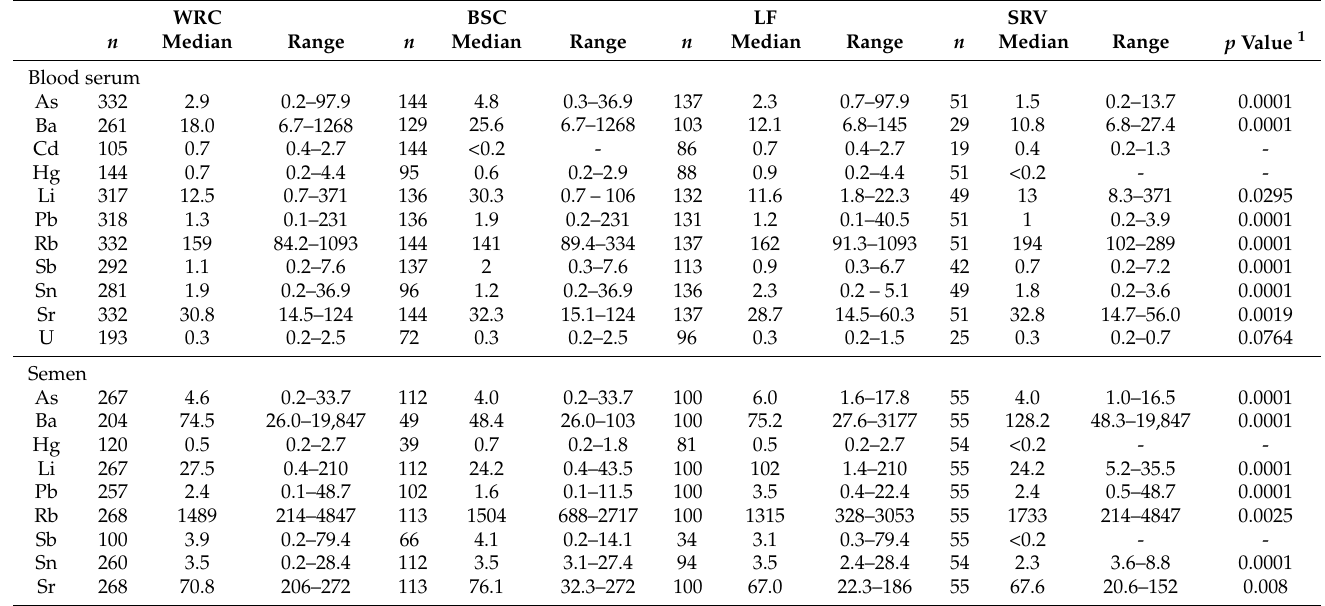
Table 3. Concentration of Groups IV and V—additional and non-essential trace elements ( µ g /L) in blood serum and semen samples of the whole cohort (WRC) and three areas (BSC, LF, SRV), reported as median values and